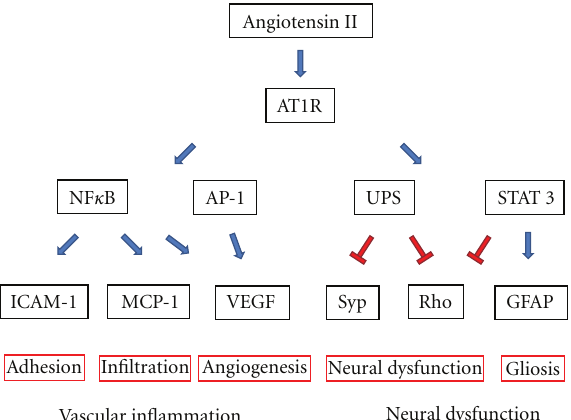
Figure 3: Downstream of AT1R in vascular inflammation and neu- ral dysfunction. NF κ B: nuclear factor kappa-light-chain-enhancer of activated B cells, AP-1: activator protein 1, UPS: ubiquitin-pro- teasome system, STAT3: signal transducer and activator of tran- scription 3, ICAM-1: intercellular adhesion molecule 1, MCP-1: monocyte chemotactic protein 1, VEGF: vascular endothelial growth factor, Syp: synaptophysin, Rho: rhodopsin, GFAP: glial fi- brillary acidic